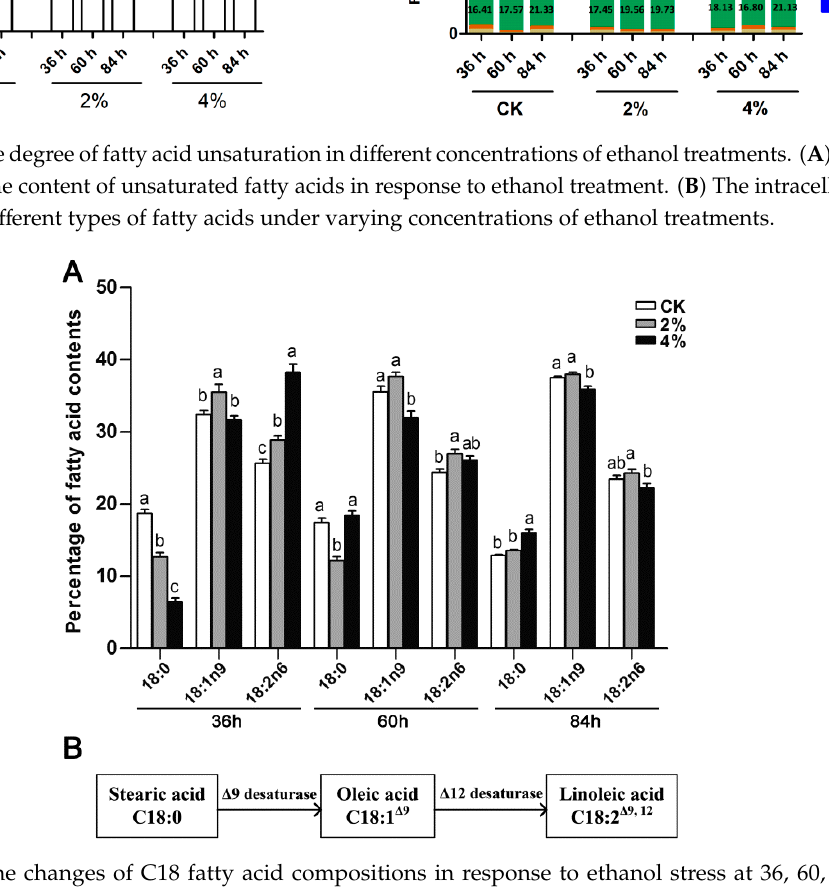
Figure 5. The changes of C18 fatty acid compositions in response to ethanol stress at 36, 60, and 84 h post-treatment ( A ). The elucidation of the linoleic acid biosynthesis pathway in Aspergillus oryzae according to KEGG pathway analysis ( B ). The bars represent the average ( ± SE) of biological repeats. Different letters above the bars indicate significant differences ( P < 0.05).